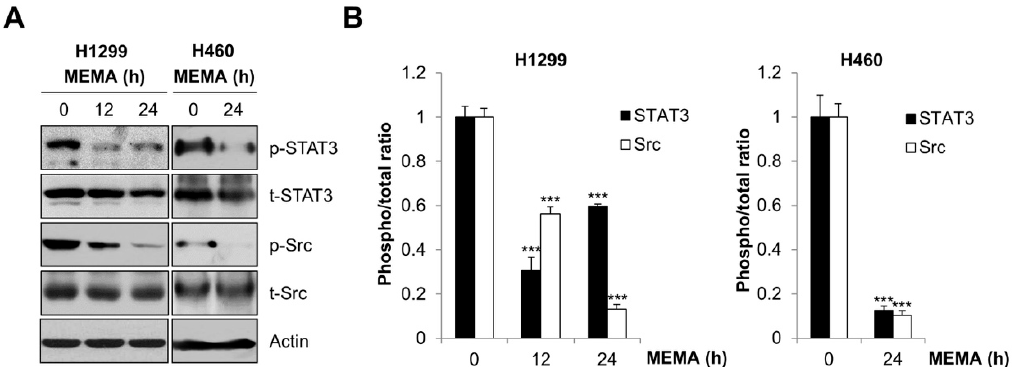
Figure 5. Effects of MEMA on the activity of Src and STAT3 in human NSCLC cells. ( A ) H1299 and H460 cells were treated with 25 or 10 µ g / mL of MEMA, respectively, for indicated time periods. The expression levels of the indicated proteins were assessed by Western blot analysis. Actin was used as a loading control. ( B ) The ratio of p-STAT3 / t-STAT3 and p-Src / t-Src was calculated using Image J software after normalization with actin. The data were expressed as the mean ± SD of three independent experiments. Significance was determined by the Student’s t -test (*** p < 0.001 versus untreated controls).